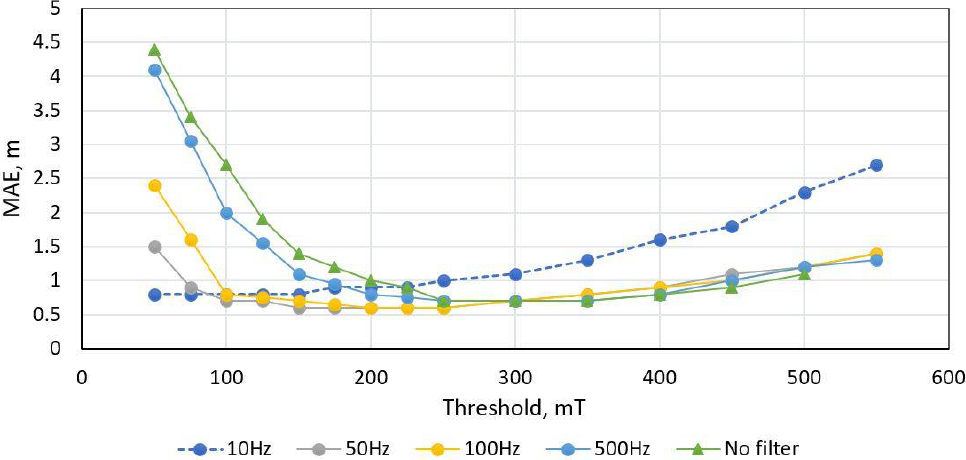
Figure 11. Peak-detection length estimation method MAE score versus low pass filtering (fc) and threshold value. Dataset of 300 unique vehicle used.